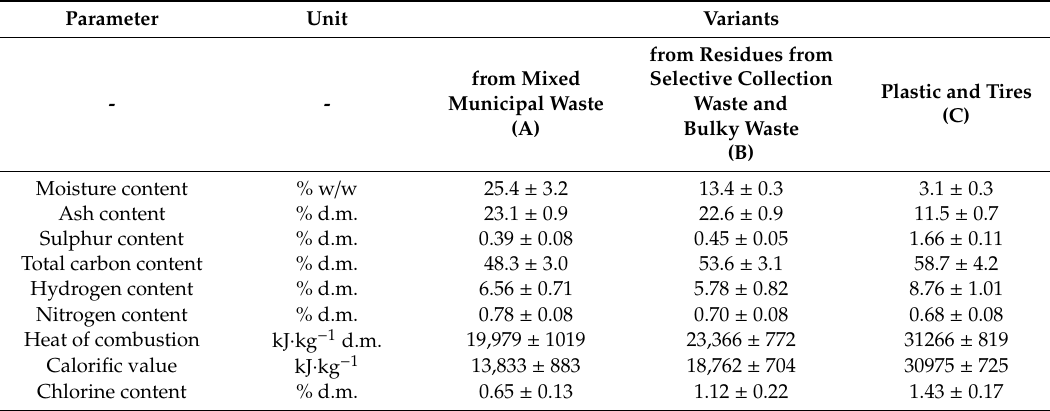
Table 1. List of basic energy characteristics of alternative fuels (own research).